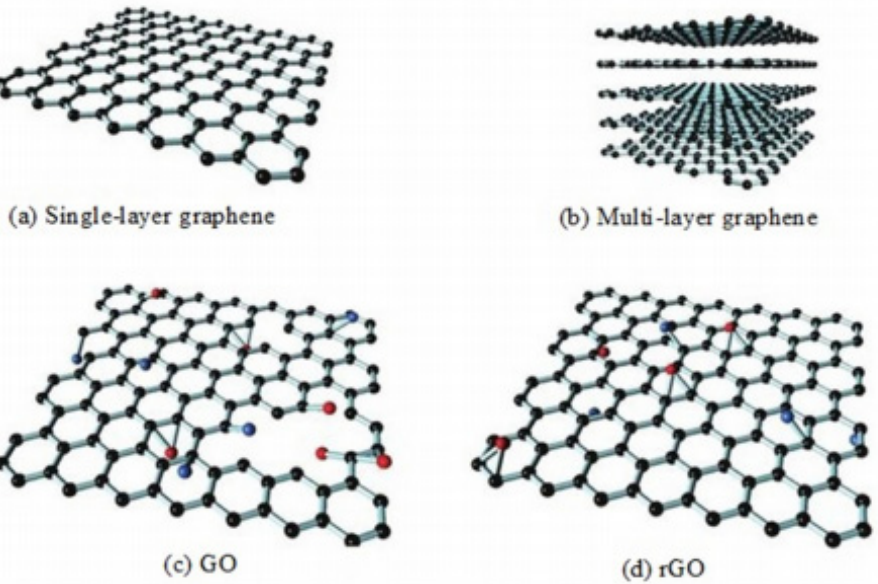
Figure 3. Structure of graphene and its derivatives. “Reproduced with permission from [19], [Materialia]; published by Elsevier, 2020”.